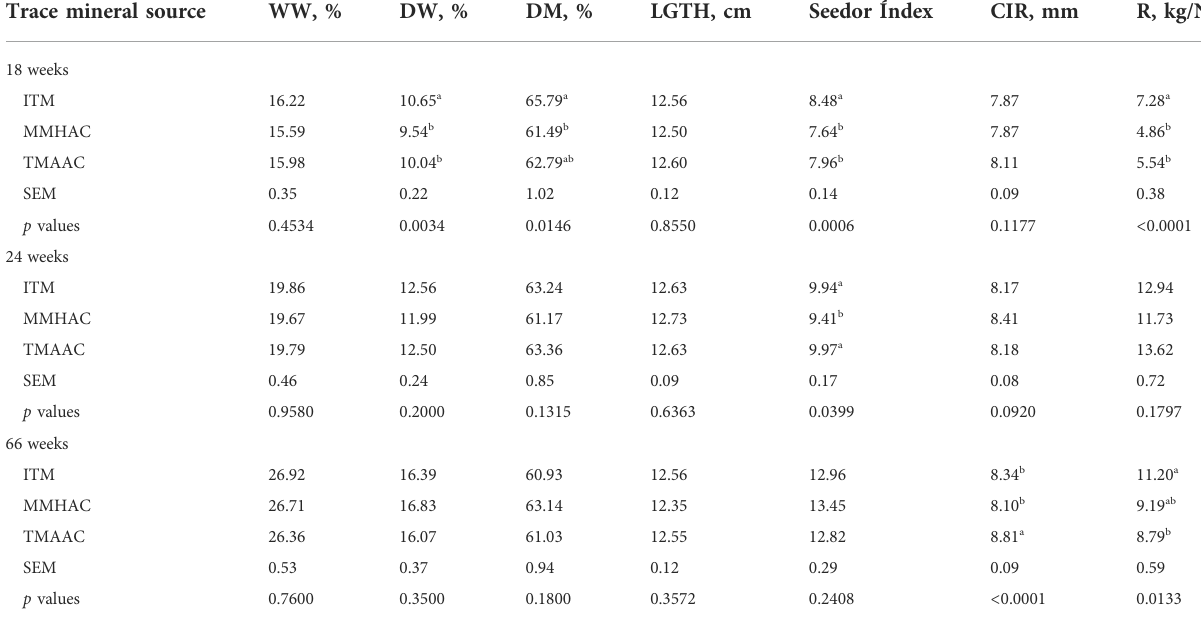
TABLE 8 Effect of feeding supplemental inorganic or organic trace minerals on bone quality. Trace mineral